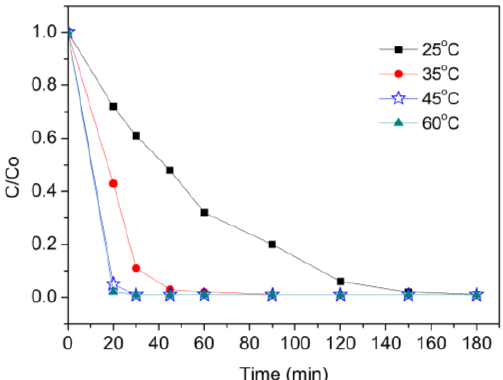
Figure 10. Effect of temperature on catalytic oxidation of AO7 [ C (AO7) = 5× 10 −5 mol/L, C (H O ) = 4.85 × 10 −2 mol/L, C (CoTCPcNa-AN-CNFs) = 0.667 g/L, 25 °C]. 2 2